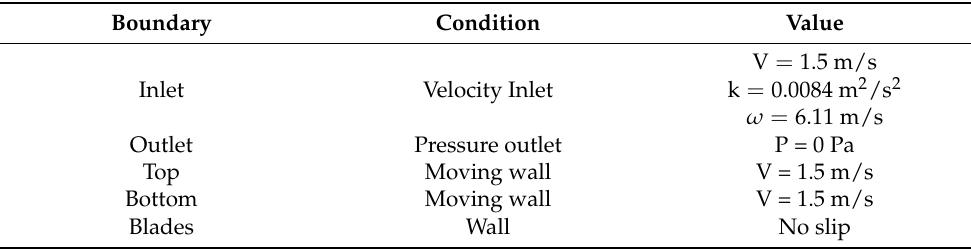
Table 5. Parameters of the boundary